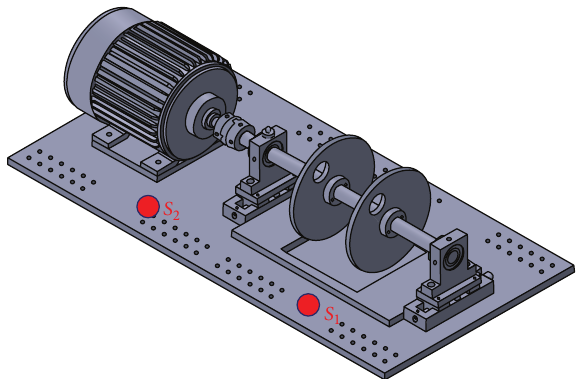
Figure 1: Illustrative model of a machine and measurement points ( 𝑆 1 and 𝑆 2